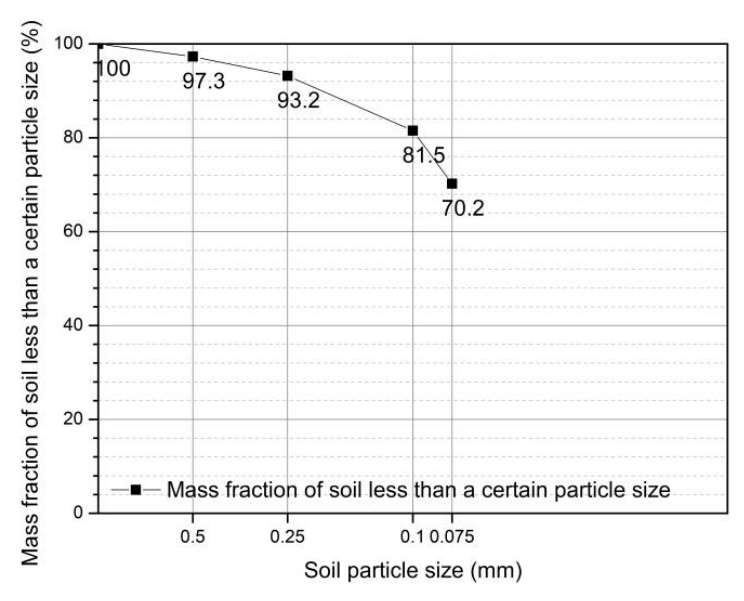
Figure 1 . Particle grading curve Figure 1. Particle grading curve.